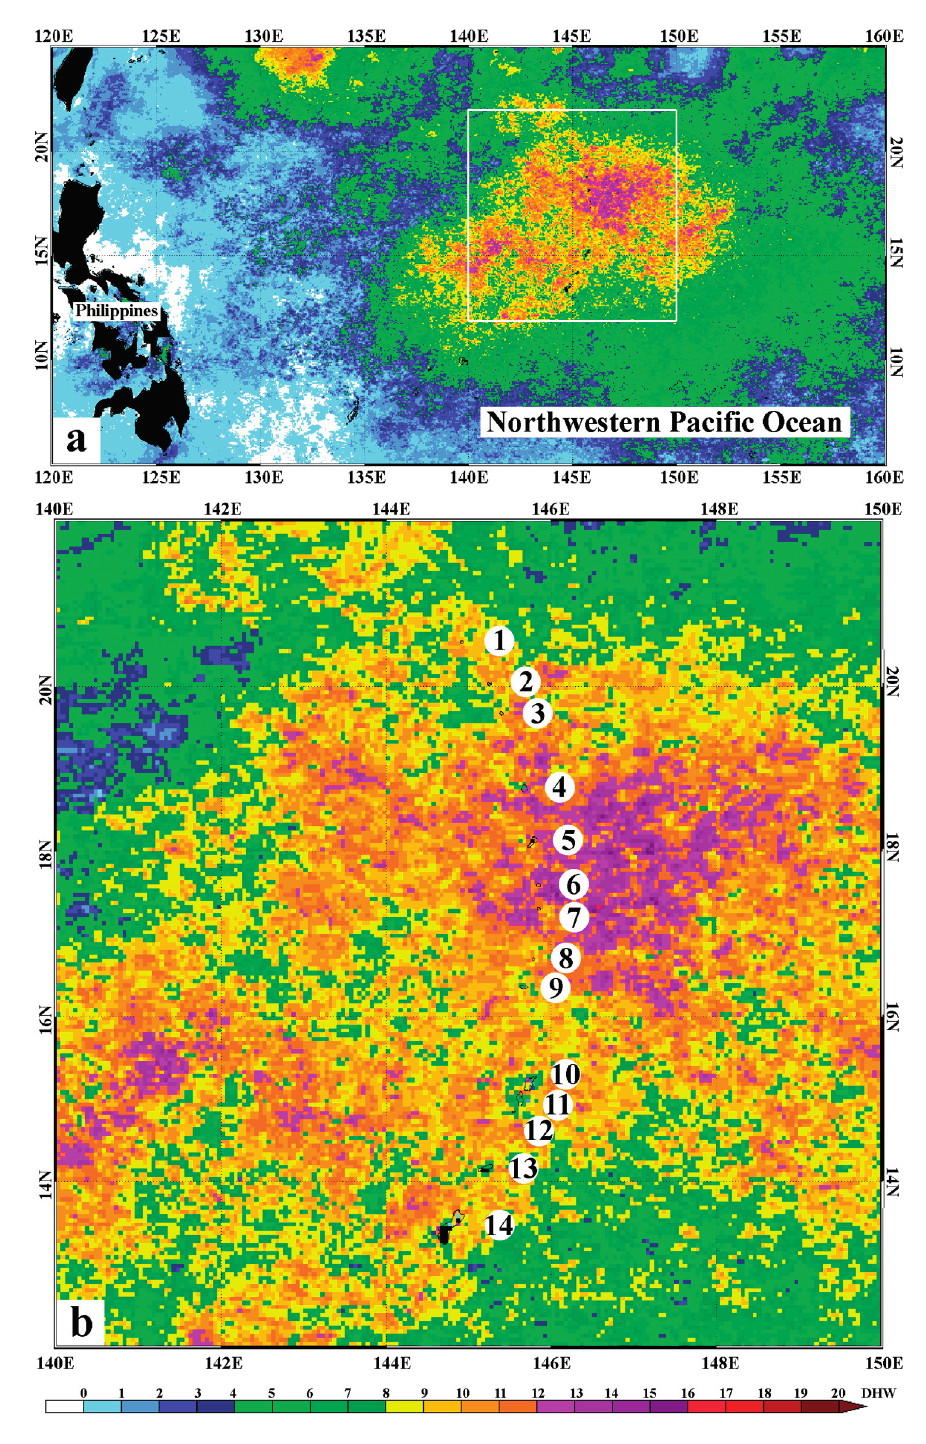
Figure 8. CRW’s daily 5-km DHW maps of the tropical northwestern Pacific Ocean ( a ) and CNMI/Guam ( b ) of 20 September 2013; the box in (a) shows the spatial coverage of